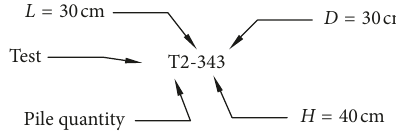
Figure 7: Illustration of the test